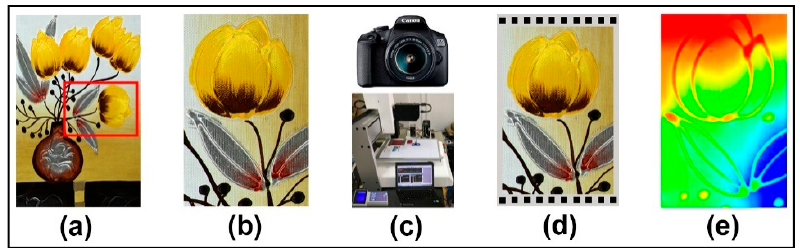
Figure 2. Diagram of 3D reconstruction of a specific area in an oil painting: ( a ) original oil painting; ( b ) target area; ( c ) key devices; ( d ) control grid array; ( e ) height contour rendering. A Canon 5D II SLR camera with a 50 mm solid focal length fixed lens was used for this study.